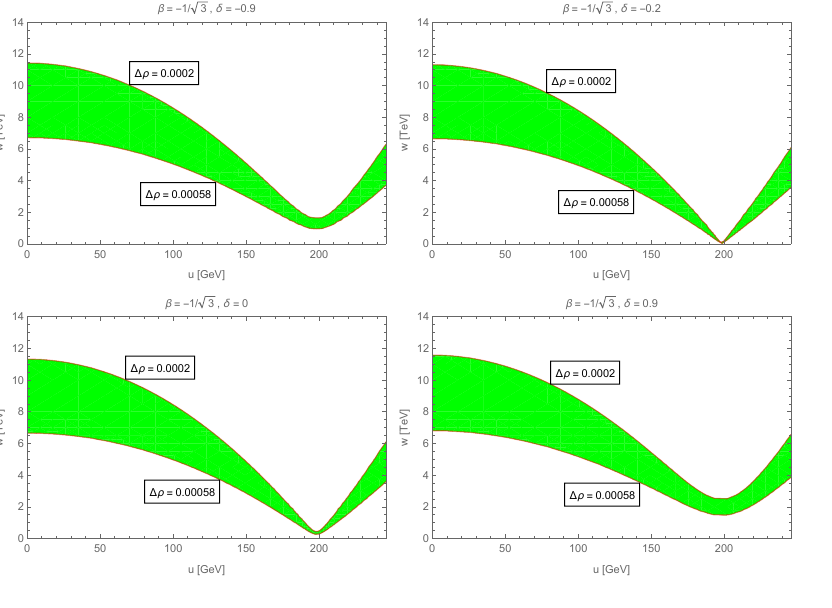
Figure 9 . The ( u, w ) regime constrained by ∆ ρ for β = Λ = 2 w , where the panels correspond to δ =